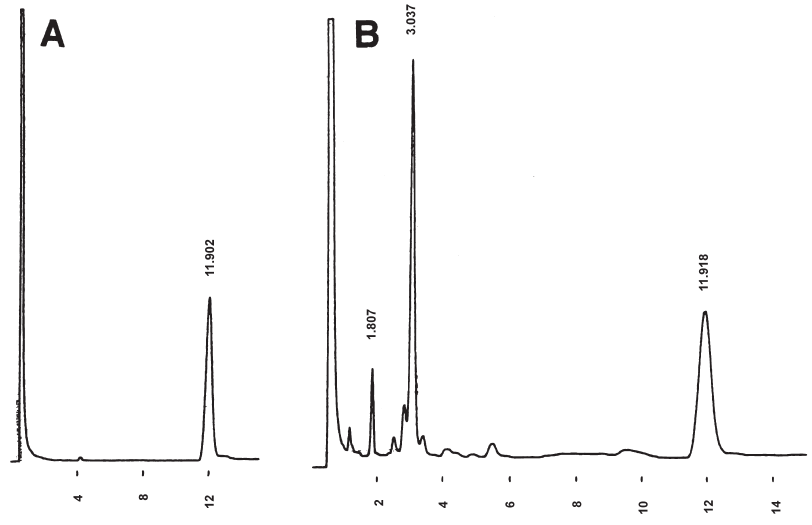
Figure 2. Gas-liquid chromatogram of hydrocarbons prepared by LiAlH 4 from a model ether lipid, 2,3-di- O - geranylgeranyl- sn -glycerol-1-phosphate. Panels A and B are the chromatograms of samples before and after reductive cleavage, respectively. The peaks eluted at 11.9 min and 3.0 min were the inter- nal standard, n -hexacosane and geranylgeranyl chain-derived hydrocar- bon (2,6,10,14-tetramethylhexa- dec-2,6,10,14-tetraene),